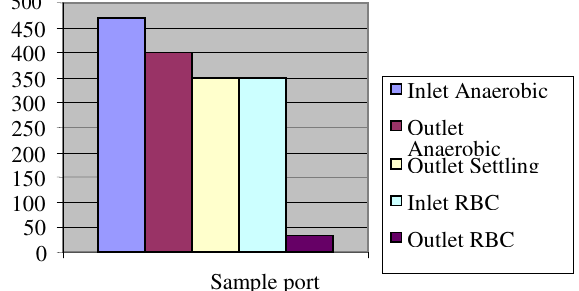
Figure 4. DOC removal in the two-stage reactor.